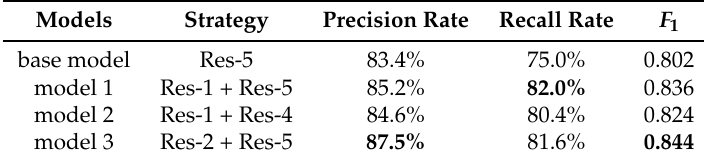
Table 5. Detection performance with different layer fusion strategies.